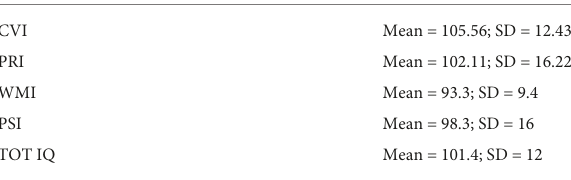
TABLE 3 WISC-IV for the ADHD group: Wechsler Intelligence Scale for Children, 4th